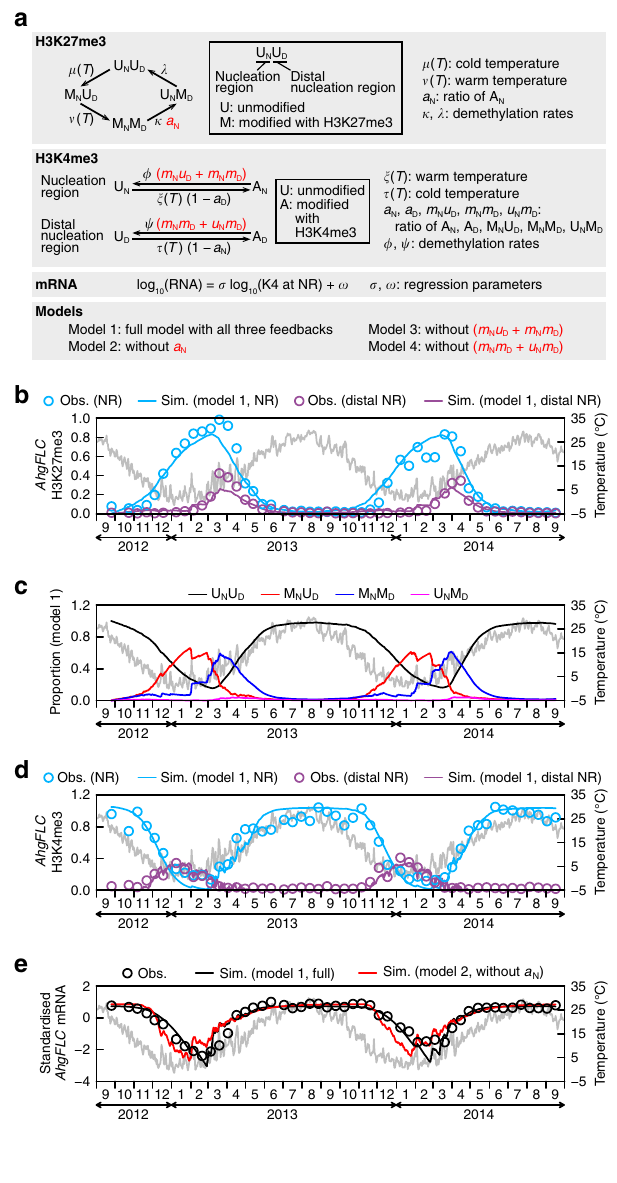
nant and transitioned swiftly into U N U D , without U N M D ever reaching a high level (Fig. 5c), indicating that H3K27me3 is removed almost simultaneously at the two nucleation regions. In